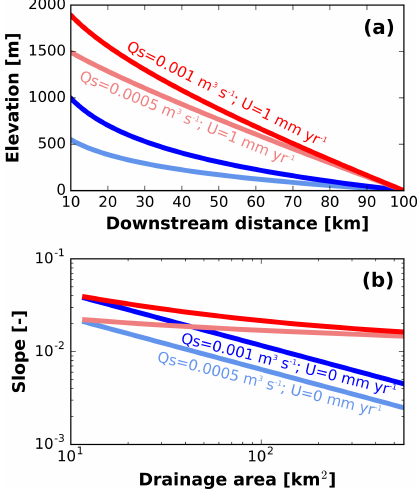
Figure 8. Covarying tectonic uplift (or base-level fall) and the in- put sediment-to-water supply ratio produces a range of channel long profiles (a) and steepness and concavity indices (b) . Changes in the tectonic uplift rate impact channel concavity indices, θ , whereas changes in the water-to-sediment discharge ratio mainly impact channel steepness indices, k s . A higher sediment supply dampens the effect of uplift on concavity. While these drivers and responses are distinct, tectonic uplift may increase sediment supply by steep- ening hillslopes; therefore, the variables controlling both the up- stream (sediment supply) and downstream (base level) boundary conditions may change at the same